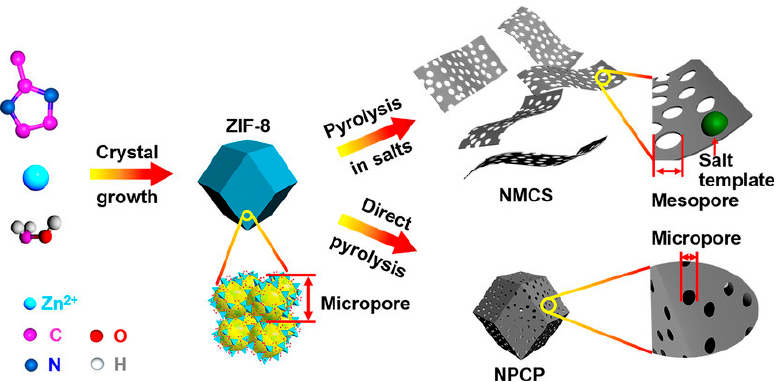
Figure 3. Synthetic procedure of NMCS and NPCPs (N-doped porous carbon polyhedrons) with or without the mediation of molten salts [64].